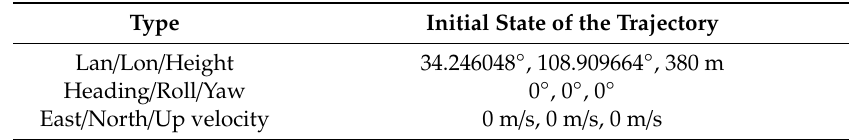
Figure 2. Horizontal trajectory and height of the simulation test. The blue, red, and yellow lines indicate the open-sky, insufficient satellite, and satellite outage context, respectively. Table 1. Initial state parameters of the trajectory.